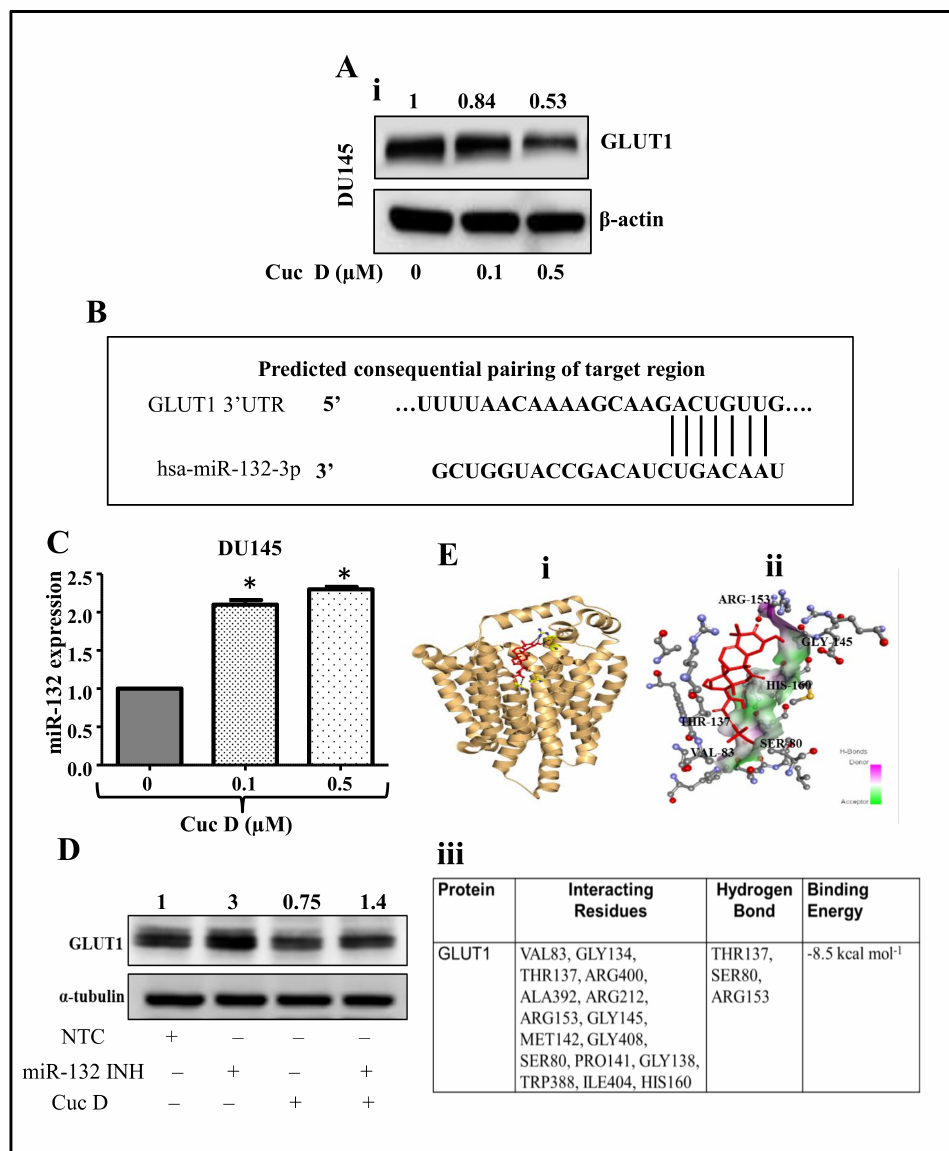
Figure 4. Molecular mechanism of Cuc D targeting GLUT1 in PrCa cells. ( A ) Effect of Cuc D on GLUT1 expression in DU145 cells ( A ) as examined by western blot analysis. Briefly, cells were treated with denoted concentrations of Cuc D for 24 h and total cell lysates were prepared and subjected for western blot analysis for GLUT1 protein level. β -actin was used as an internal loading control. Values shown above the blot are densitometric analysis of GLUT1 blot normalized with β -actin using GelQuant software. ( B ) Putative miR-132 binding sites in the SLC2A1 3 (cid:48) UTR region of GLUT1. Seven bases (192 through 198) of the SLC2A1 3 (cid:48) UTR are perfect matches (seed sequences) for miR-132 binding. ( C ) Effect of Cuc D on the expression of miR-132 in PrCa as determined by qPCR analysis. RNU6B was used as an internal control. Asterisk (*) denotes the significant value p < 0.05 when applied student’s t -test. ( D ) Effect of Cuc D on GLUT 1 expression after transfection of the cells with miR-132 inhibitor as determined by western blot analysis. α -tubulin was used an internal loading control. ( E ) Molecular docking studies of Cuc D with GLUT1 as determined by AutoDock 4 package. Cartoon view of Cuc D docked with GLUT1 protein ( Ei ). Stereo view of GLUT1 binding with Cuc D, showing hydrogen bond donors and acceptors residues around components ( Eii ). Table depicting the GLUT1 residues interacting with Cuc D ( Eiii